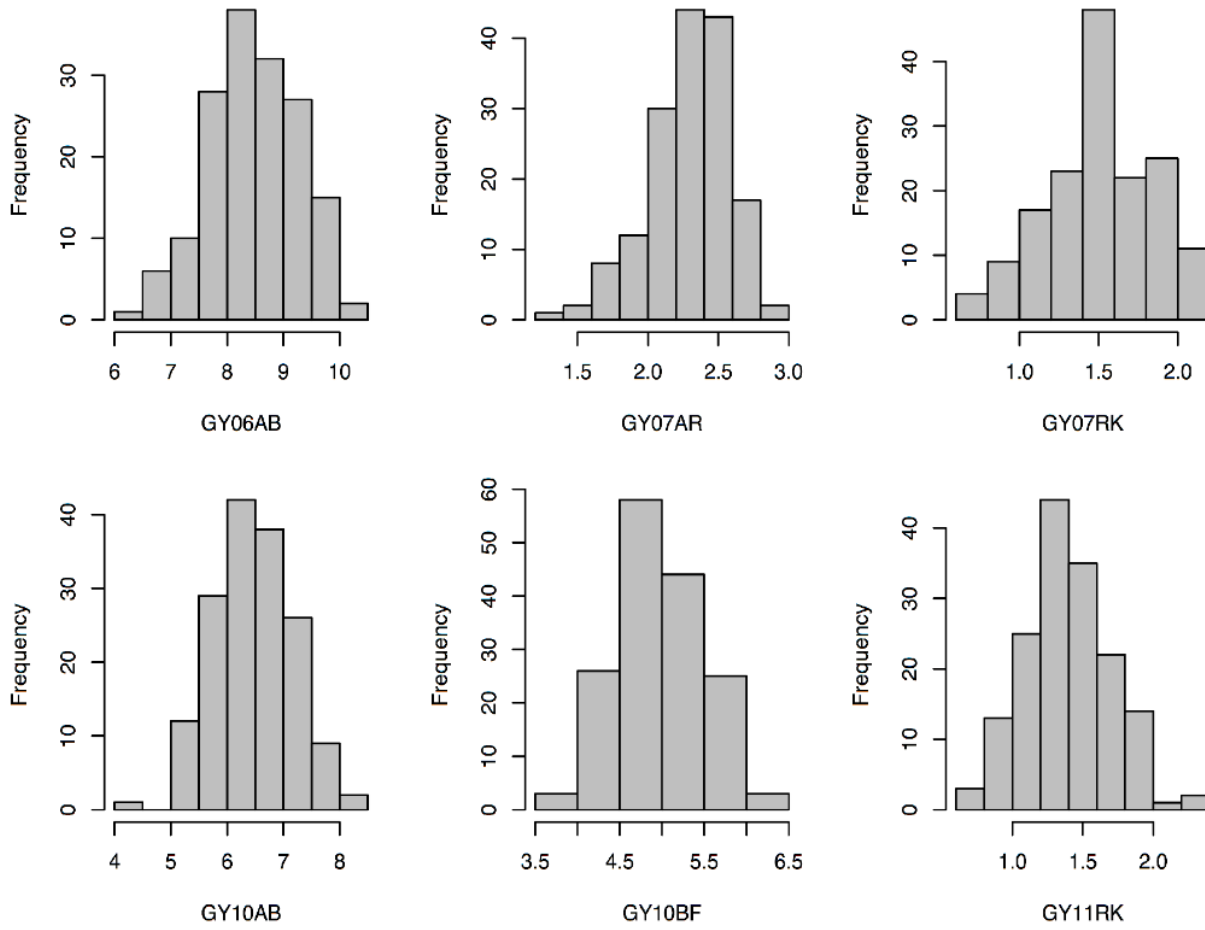
Figure 1. Histograms of grain yield in six